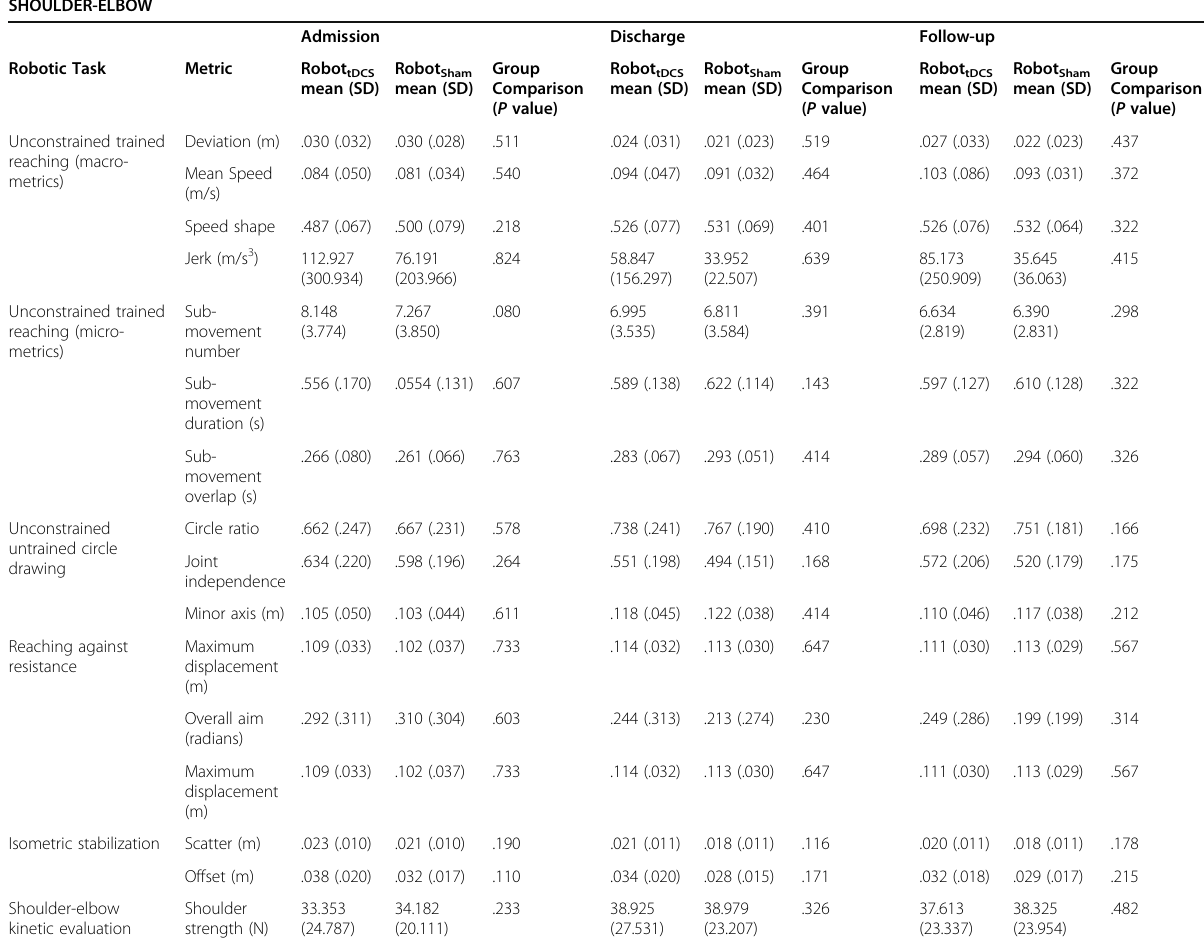
Table 2 Comparison of Robot tDCS and Robot Sham kinematic and kinetic metrics at admission, discharge, and follow-up for